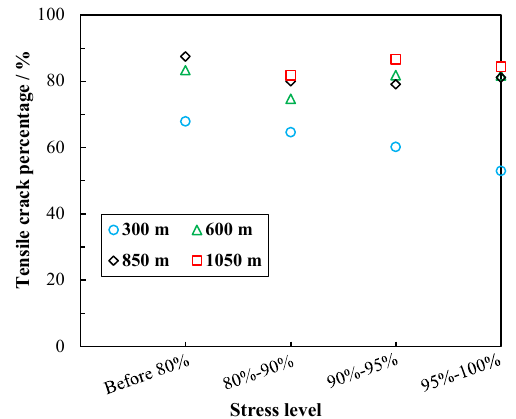
Figure 10. Tensile crack percentage during different stress stages of the coal sample at specific depths.